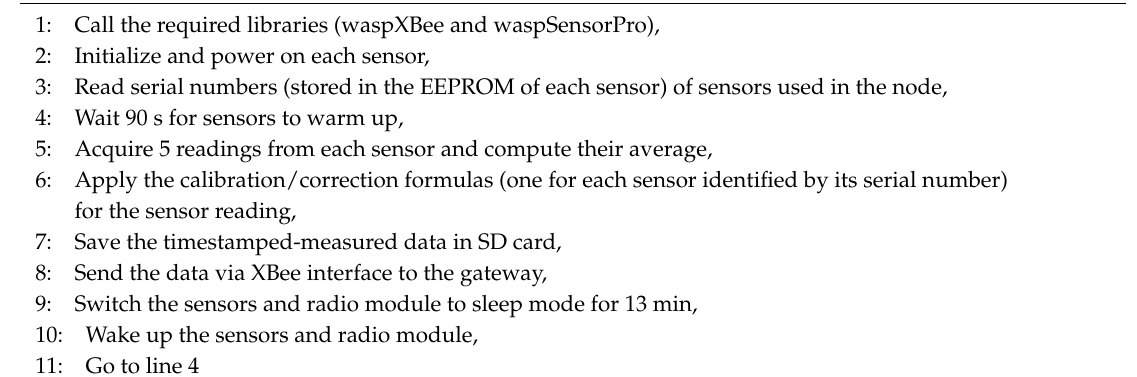
Algorithm 1. Pseudo code of the Firmware at the sensor node operated in the measurement mode